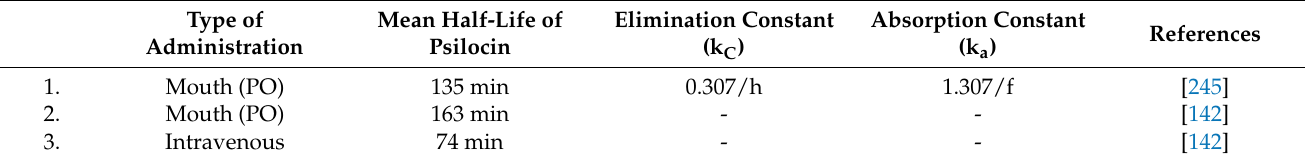
Table 7. Basic pharmacokinetics of